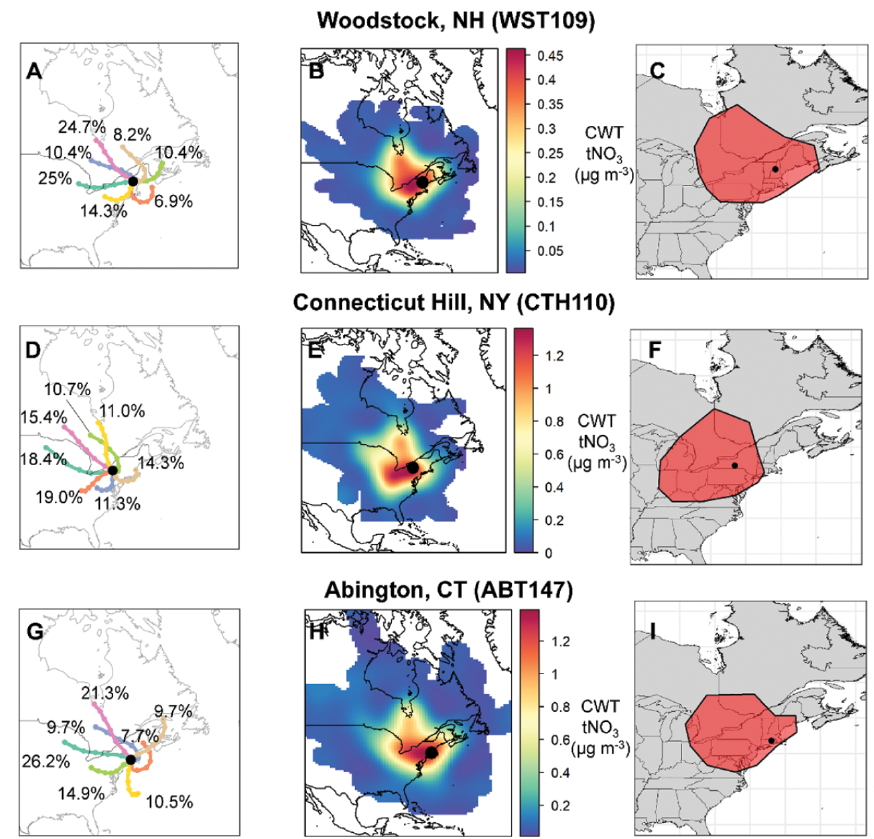
Figure 3. Clustered air mass back trajectories (a, d, g) , total nitrate (tNO 3 = HNO 3 + pNO 3 ) concentration weighted trajectories (b, e, h) , and geospatial polygons (shown in red) representing the tNO 3 source contribution regions (c, f, i) at the CASTNET sites from December 2016 to 2018. The percentage contribution of each cluster to the total is also